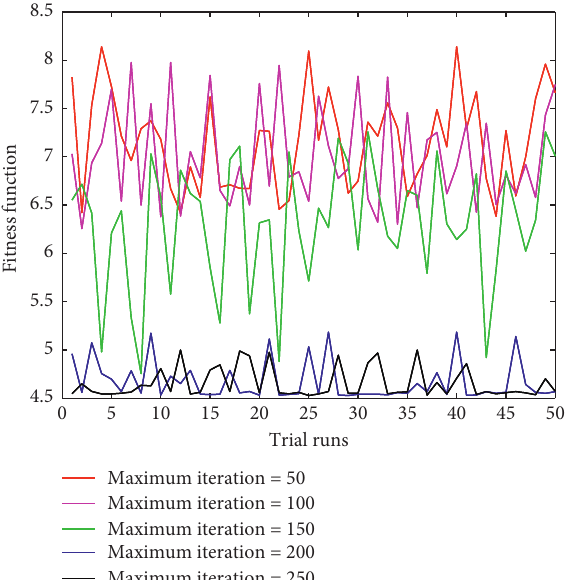
Figure 2: The impact of the maximum iteration on obtained fitness values of 50 trial runs.